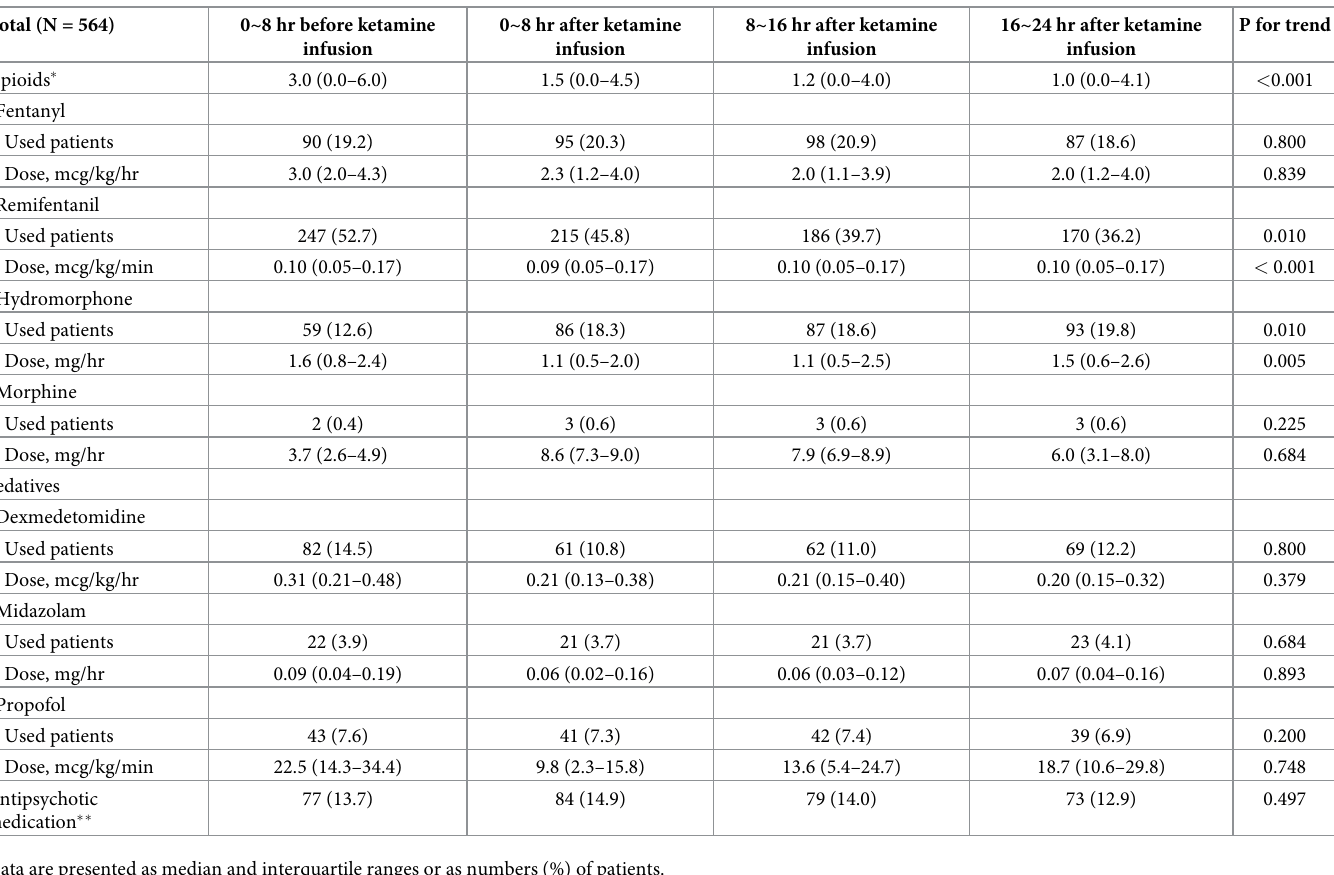
Table 5. Trends of analgesic and sedative interventions during continuous ketamine infusion. Total (N =